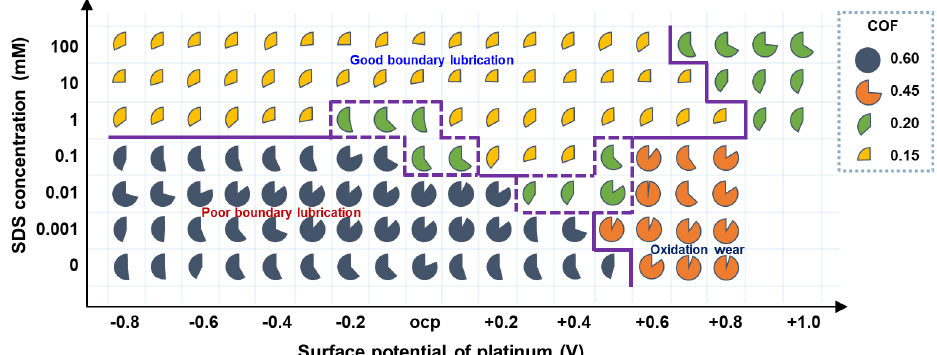
Fig. 6 Friction behavior of Pt/ZrO 2 tribo-pairs lubricated with different concentrations of SDS aqueous solutions under different surface potentials.